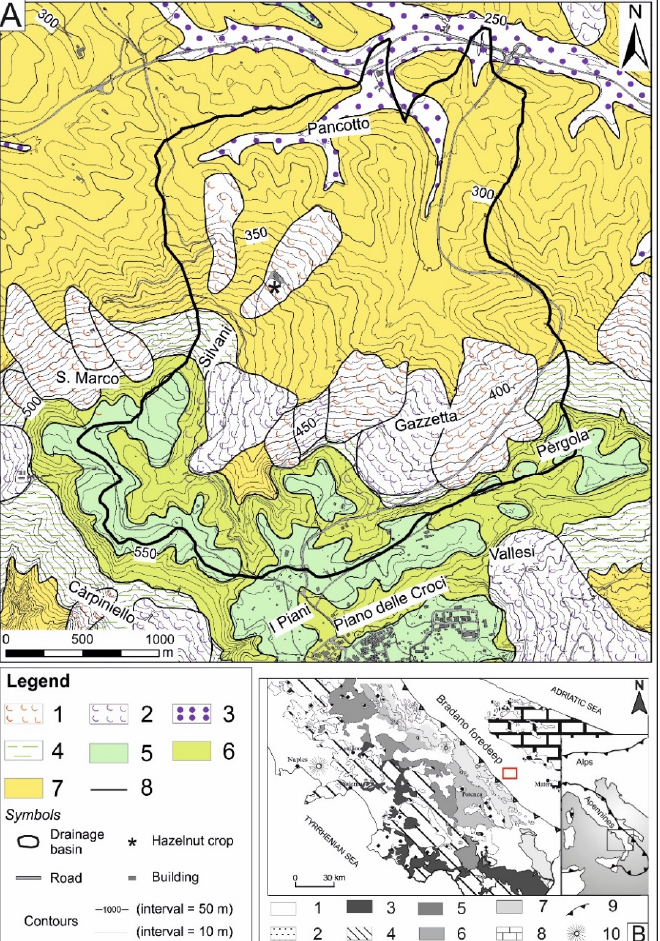
Figure 3. ( A ) Geological map of the study area. Legend: (1) Landslide deposits with evidence of recent activity represented by chaotic and heterogeneous deposits (a1a, Holocene); (2) ancient landslide deposits constituted by chaotic and heterometric blocks embedded in a fine grained matrix (a1b, Upper Pleistocene—Holocene); (3) gravel and sand deposits of present-day thalwegs (Holocene); (4) eluvial-colluvial deposits made by fine-grained sediments or eluvial products with heterogenous clasts (Holocene); (5) massive grain- and matrix-supported conglomerates with a rare lens or levels of sands and silty clays (Lower–Middle Pleistocene); (6) stratified fine- to medium-grained yellowish marine sands (Lower Pleistocene); (7) marine grey- blue clays and silty clays (Upper Pliocene—Lower Pleistocene); (8) Stratigraphic contact. ( B ) Geological sketch map of the southern Apennines. The study area is represented in the red box. Legend: (1) Pliocene to Quaternary clastic deposits and volcanic products; (2) Miocene syntectonic deposits; (3) Cretaceous to Oligocene ophiolite-bearing internal units; (4) Mesozoic–Cenozoic shallow-water carbonates of the Apennines platform; (5) lower– middle Triassic to Miocene shallow-water and deep-sea successions of the Lagonegro-type Monte Arioso unit; (6) Mesozoic to Miocene deep-sea successions of the Lagonegro-type Groppa d’Anzi unit; (7) Cretaceous to Miocene deep-sea successions of the Lagonegro-type Campomaggiore unit; (8) Mesozoic–Cenozoic shallow-water carbonates of the Apulian platform; (9) thrust front of the chain; (10)